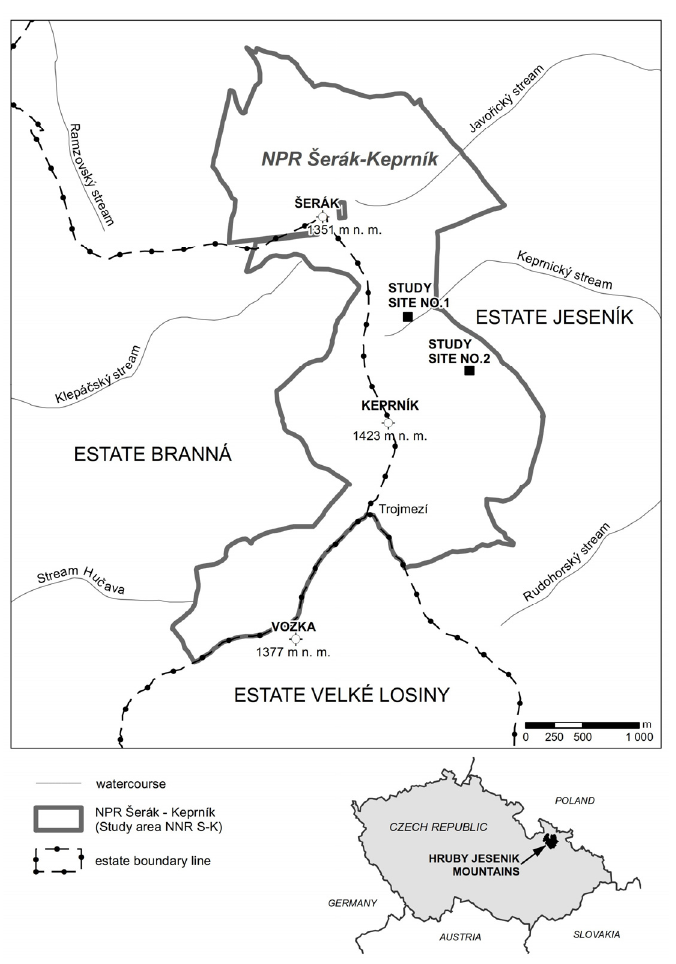
Figure 1. Location of the study area National Nature Reserve Serak ‐ Keprnik in the Czech Republic and location of the study sites 1 and 2 in the frame of the study area.